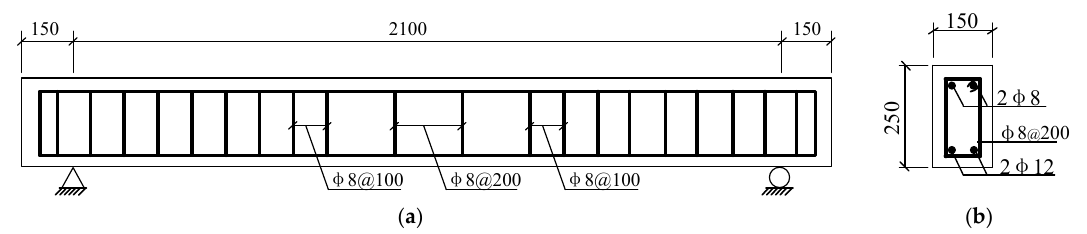
Figure 1. Geometric configuration of the experimental reinforcement concrete (RC) beam and anchorage device (units: mm): ( a ) geometric shape and sizes of the RC beam; ( b ) the reinforcement distribution, shape, and sizes of cross-section. Table 1. C20 concrete mix ratio.